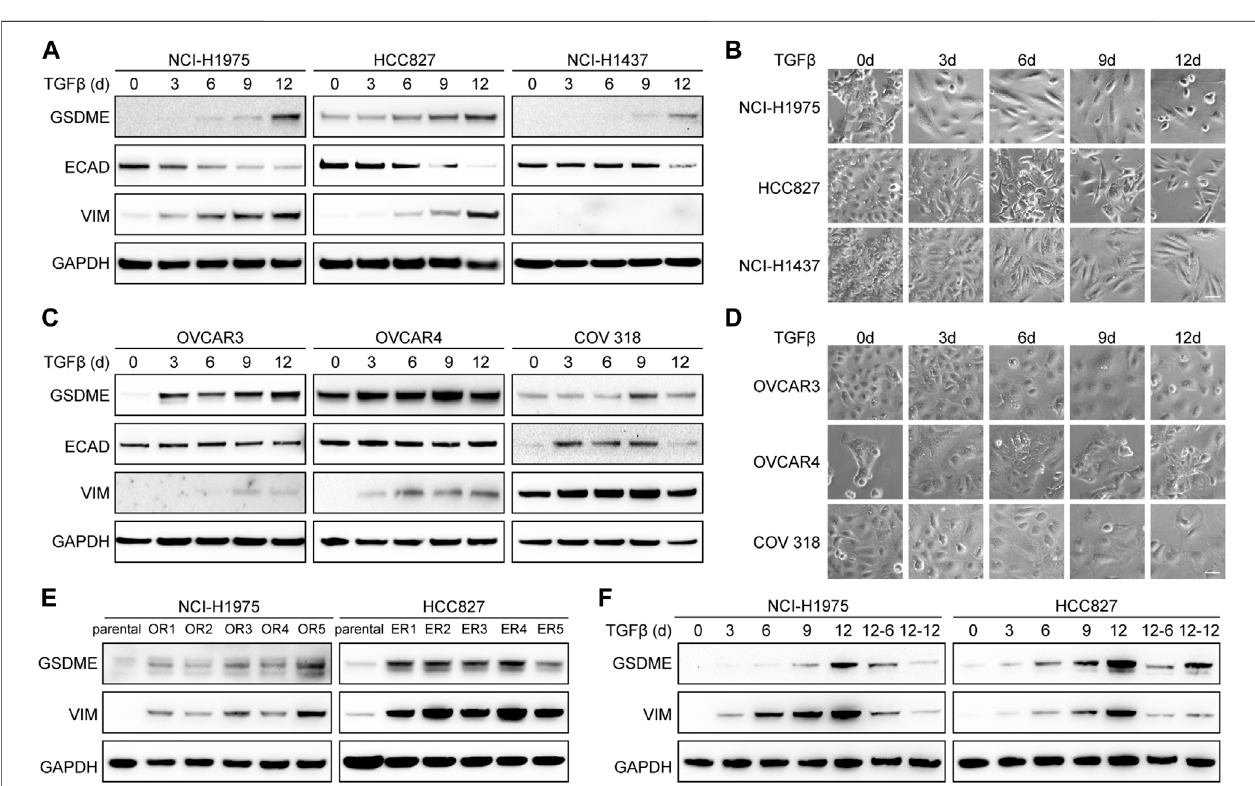
FIGURE 2 | Reversible GSDME upregulation during EMT. (A) Three indicated lung cancer cell lines were treated with TGF β (5 ng/ μ l) at a time course manner and analyzed by Western blot for GSDME protein expression. (B) Imaging analysis of lung cancer cells showed EMT morphology upon TGF β treatment (scale bar (cid:1) 50 μ m). (C) Three indicated ovarian cancer cell lines were treated with TGF β (5 ng/ μ l) at a time course manner and analyzed by Western blot for GSDME protein expression. (D) Imaging analysis of ovarian cancer cells showed EMT morphology upon TGF β treatment (scale bar (cid:1) 50 μ m). (E) Osimertinib-resistant NCI-H1975 (OR) and erlotinib-resistant HCC827 (ER) cells were generated by long-term culture and analyzed by Western blot for GSDME protein expression. (F) NCI-H1975 and HCC827 cells were treated with TGF β (5 ng/ μ l) to induce EMT. TGF β was withdrawn as indicated and cells were analyzed by Western blot for GSDME protein expression.